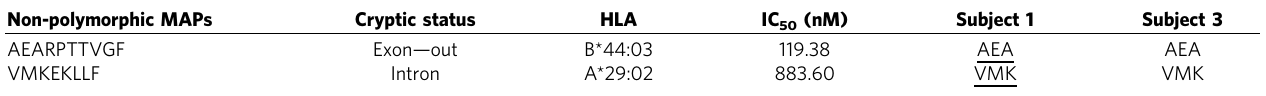
Table 2 | Features of non-polymorphic cryptic MAPs presented in Fig. 7. Non-polymorphic MAPs